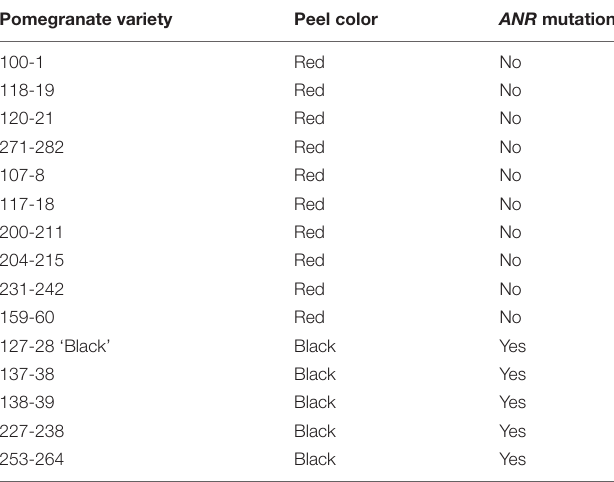
TABLE 3 | The ANR mutation is unique to the “black” varieties in the Newe Ya’ar pomegranate